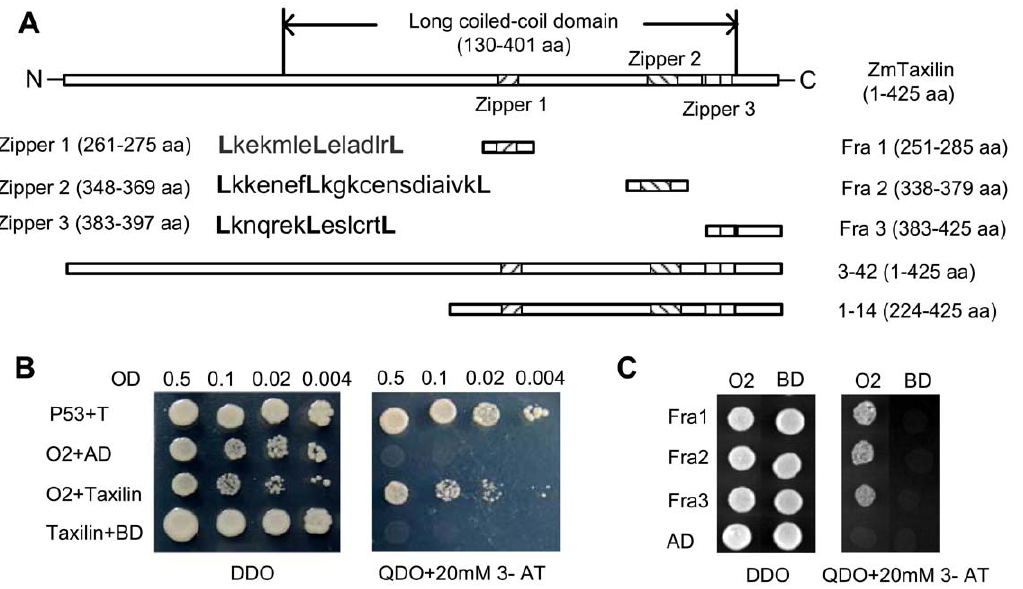
Fig. 2C, cells co-transformed with pGADT7-Rec m -Fra1/2/3 and pGBKT7-O2 grew well on QDO + 20 mM 3-AT plates while cells transformed with any construct along with the responding empty vector did not grow. These data indicate that each of the three zippers is sufficient to interact with the full length ZmO2.